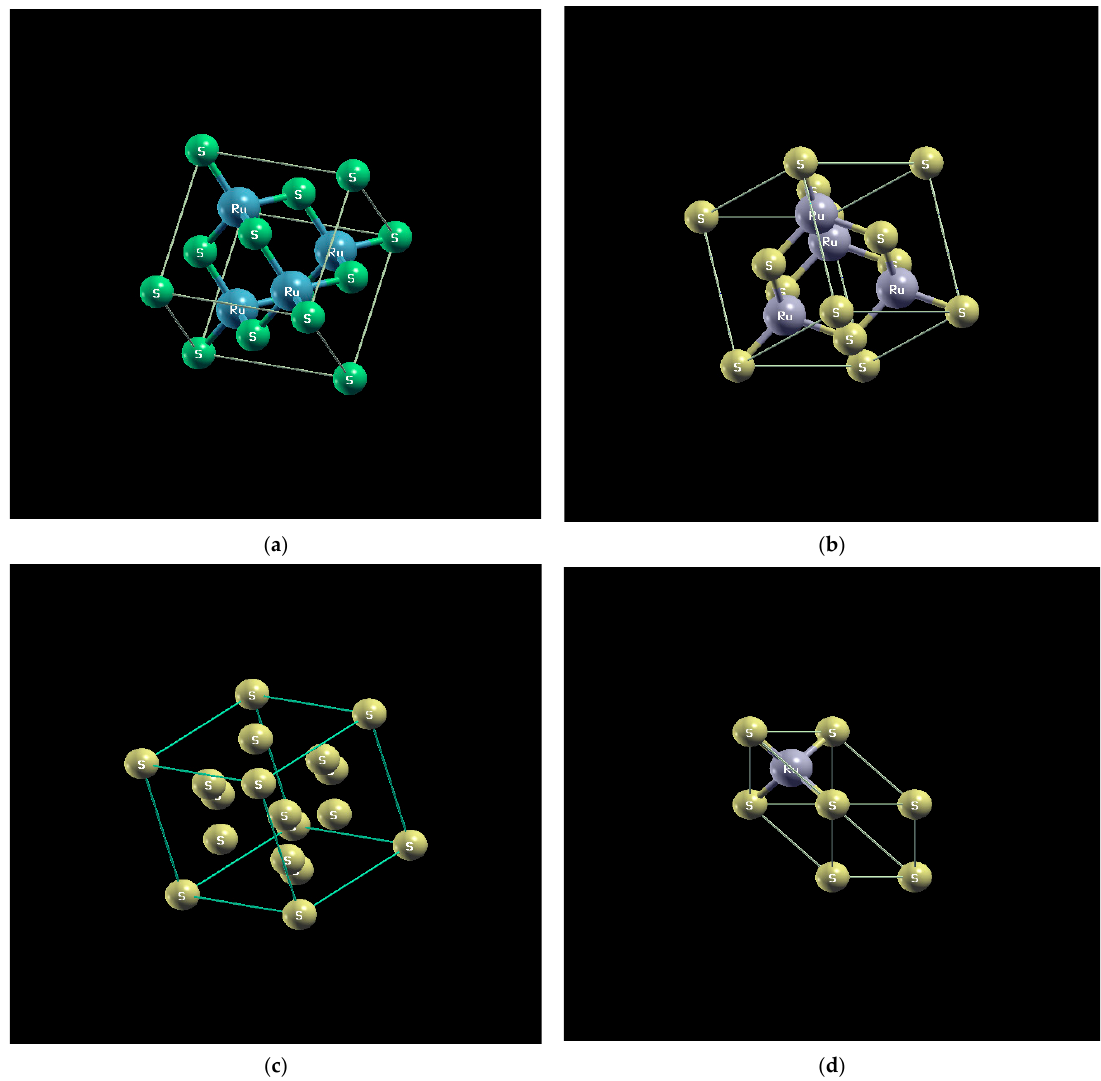
Figure 7. ( a ) crystallographic structure of Pyrite RuS 2 , ( b ) crystallographic structure of pyrite RuS 2 , ( c ) crystallographic structure of pyrite S 2 , and ( d ) primitive cell of RuS 2